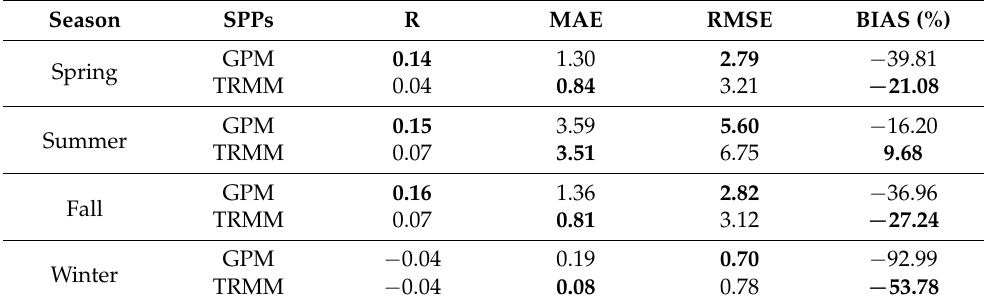
Table 4. The four evaluation metrics pertinent to the GPM and TRMM at the grid scale in various seasons. Season SPPs R MAE RMSE BIAS (%) GPM 0.14 Spring